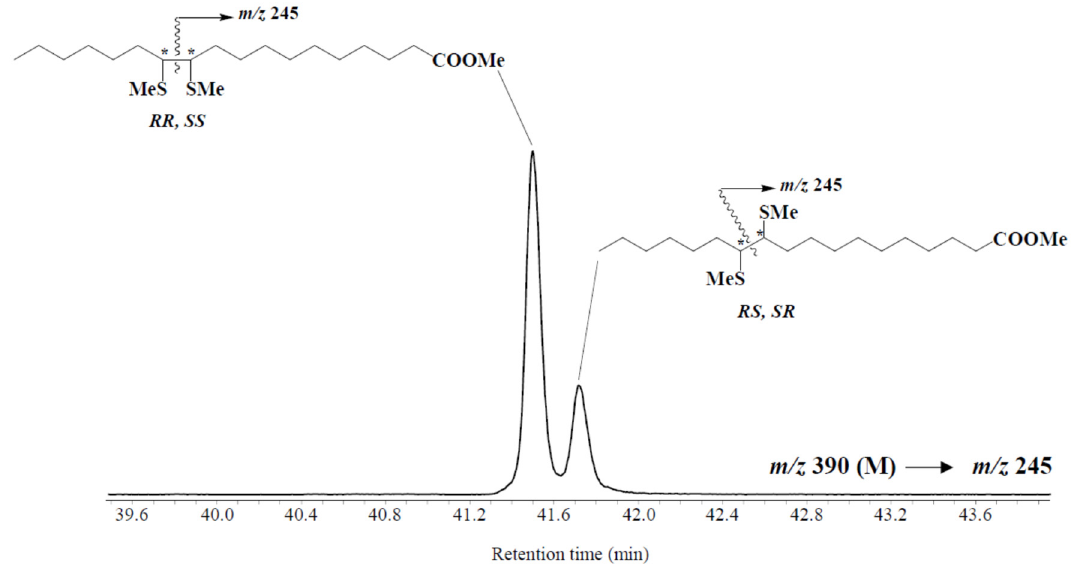
Figure 2. MRM chromatograms ( m/z 390 → 245) of DMDS derivatives of vaccenic acid in superficial bottom sediment (0–1 cm) collected at St. 428. (*) asymmetric carbon